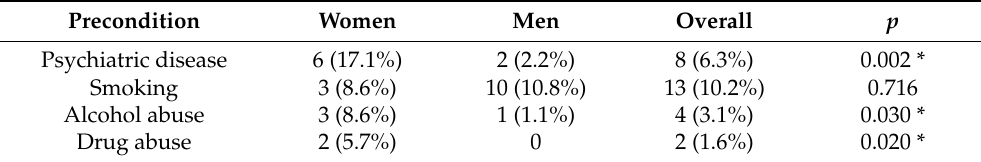
Table 2. Substance abuse and psychiatric preconditions according to retrospective